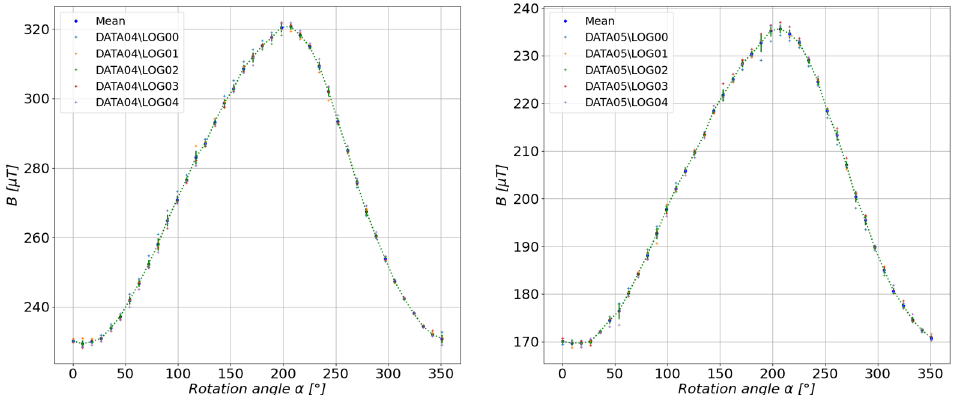
Figure 12. Measurement results at a distance of 8 cm ( left ) and 9 cm ( right ) from the center of the tested configuration.